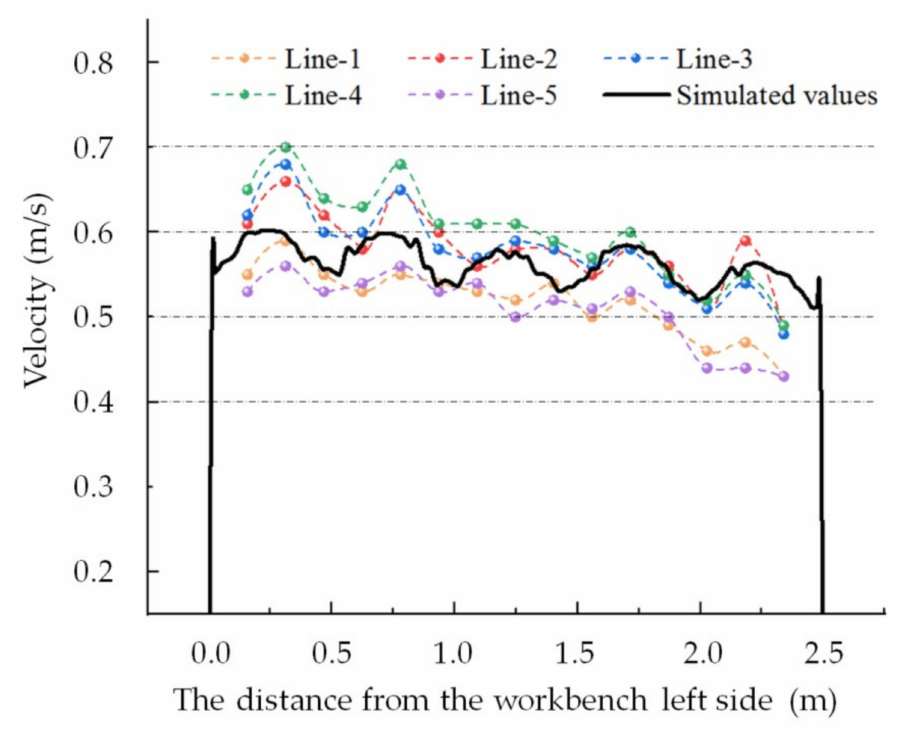
Figure 11. Measured velocities along five lines and simulated velocities along the